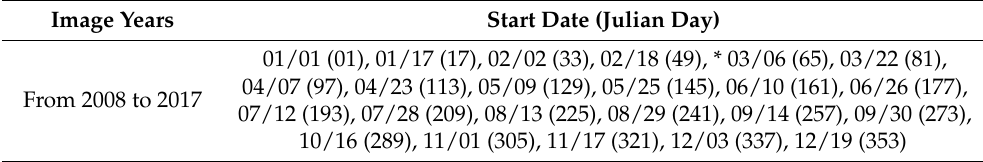
Table 1. Dates of the MODIS images.